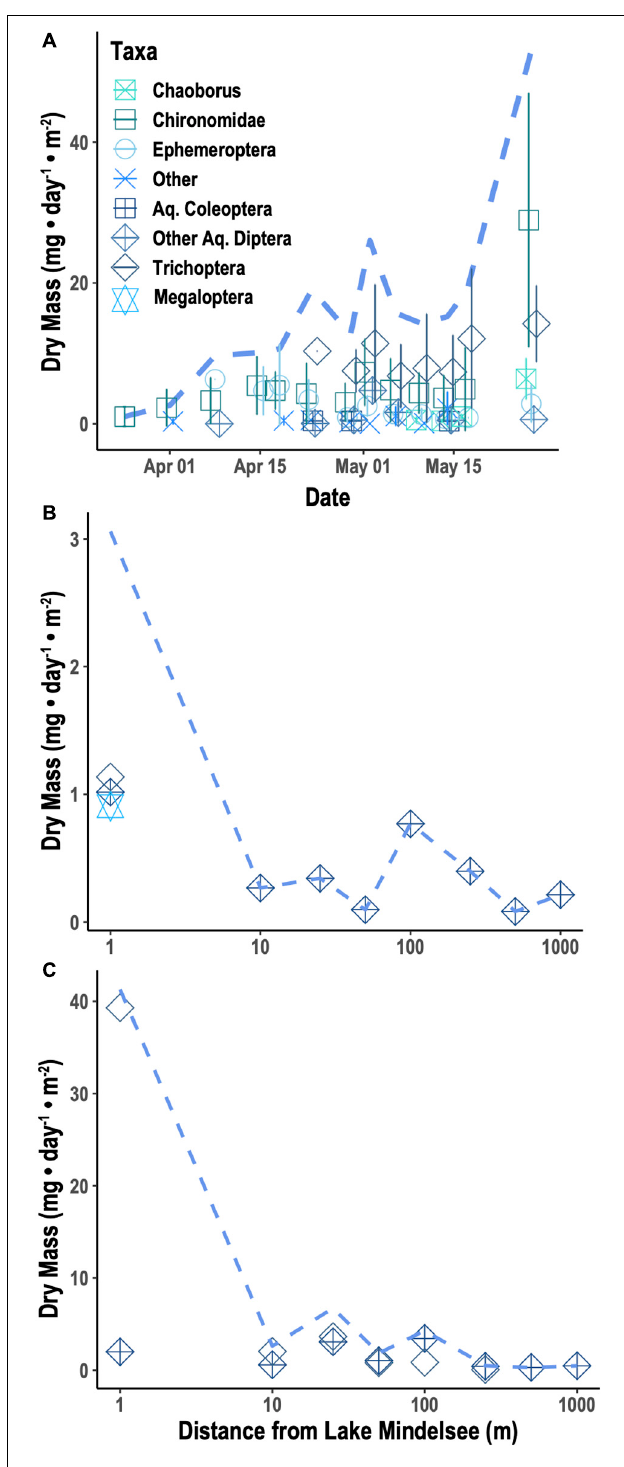
FIGURE 1 | Emergent aquatic insect biomass for individual taxa means (points) and total mean emergent aquatic insect biomass (dashed line) from (A) means ( ± 1 SD) of biomass per taxa from emergence traps, (B) mean biomass of aquatic insects from Malaise traps with distance from Lake Mindelsee in April, and (C) mean biomass of aquatic insects from Malaise traps with distance from Lake Mindelsee in